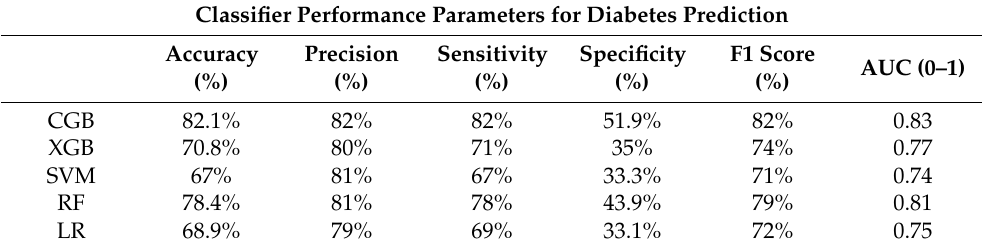
Table 7. Classifier performance of five classifiers in predicting diabetes. Classifier Performance Parameters for Diabetes Prediction